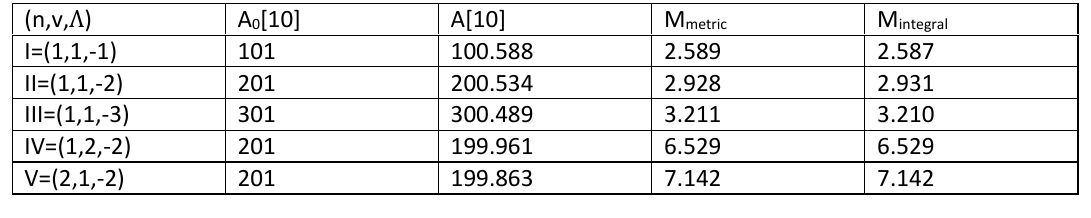
Table 1 . Table with values of the metric A 0 and A at r = 10 , M metric evaluated using A 0 and A in eq. (3.4) and M integral evaluated using the integral mass formula (3.7). The two masses match (agree to two decimal places and sometimes at three decimal